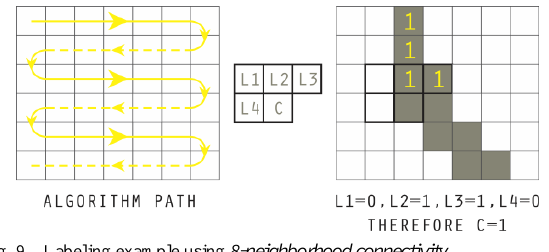
Fig. 9. Labeling example using 8-neighborhood connectivity .